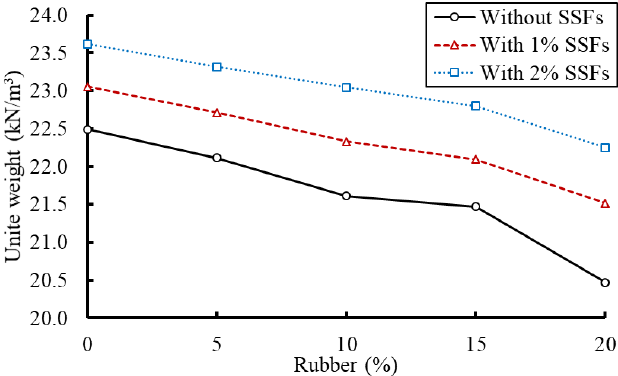
Figure 7. Effect of CR and SSFs on unit weight.